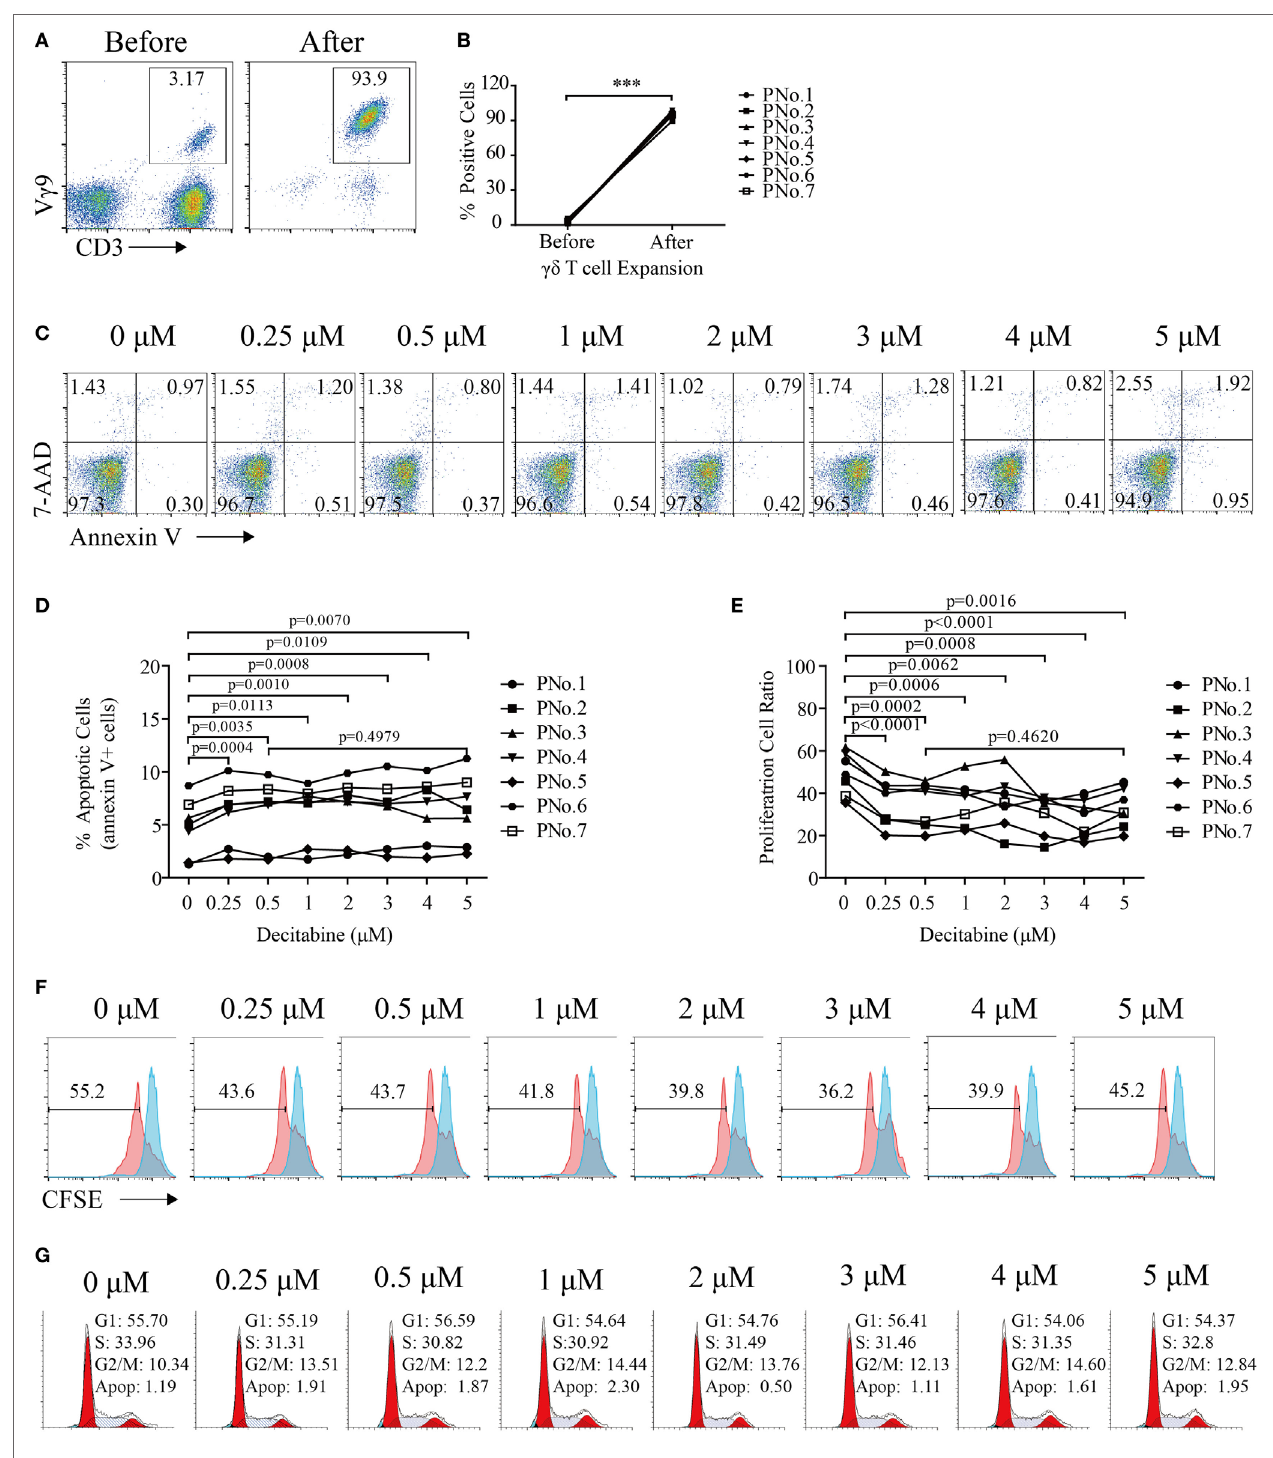
FigUre 1 | Decitabine inhibited the proliferation of gamma delta ( γδ ) T cells. (a) Representative flow cytometry analysis of CD3 + V γ 9 + γδ T cells before and after expansion. (b) Percentage of γδ T cells before and after expansion (*** p < 0.001; n = 7). (c) Viability of expanded γδ T cells after exposure to various DAC concentrations for 48 h. One representative experiment is shown. (D) Graph showing the apoptosis of expanded γδ T cells from seven patients after DAC treatment. The apoptosis percentages are shown as the percentage of cells that were annexin-V-positive. (e) Graph showing the proliferation of γδ T cells treated with increasing doses of DAC for 5 days. (F) Proliferation of γδ T cells treated with increasing doses of DAC. The red peaks represent the results of carboxyfluorescein succinimidyl ester (CFSE)-labeled γδ T cells after treatment with increasing concentrations of DAC for 5 days. The blue peak represents CFSE-labeled γδ T cells before DAC treatment. (g) Cell cycle of γδ T cells treated with increasing doses of DAC for 48 h.